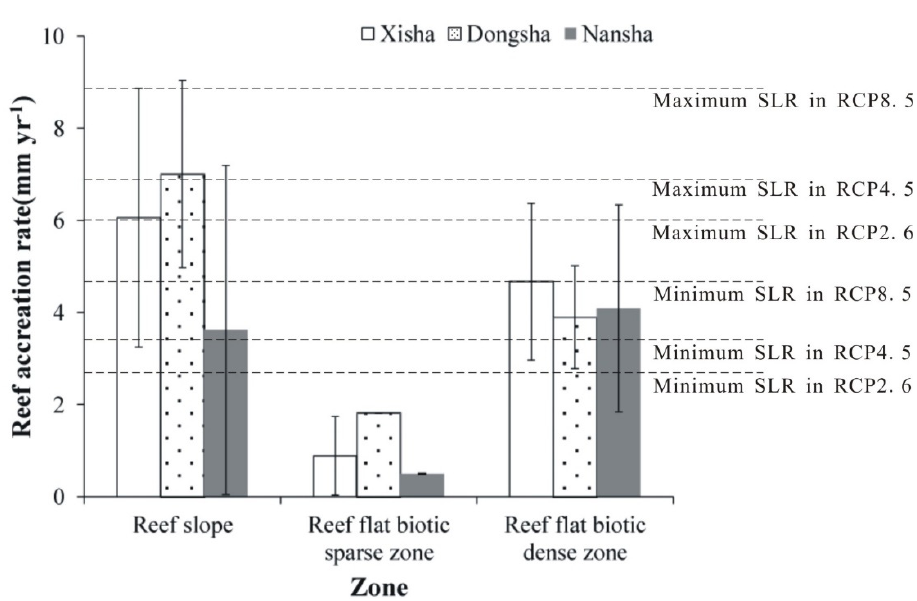
Figure 4. Reef accretion rate in geomorphic or ecological zones in the Xisha Islands, Dongsha Islands and Nansha Islands and the extreme (minimum and maximum) sea-level rise (SLR) under RCP2.6, RCP4.5, and RCP8.5 in the South China Sea